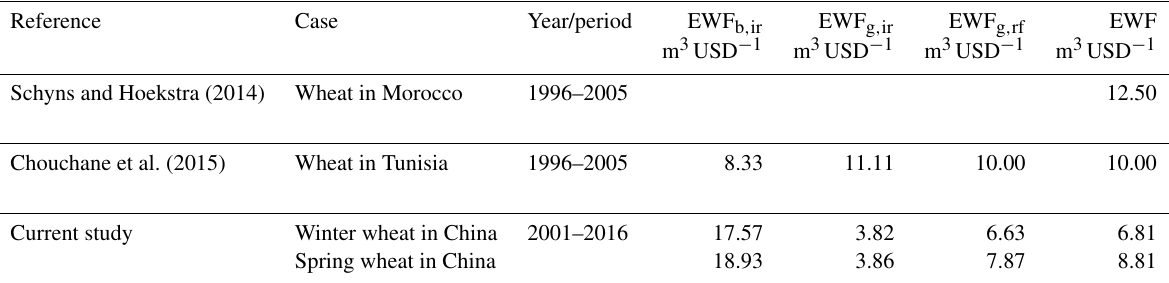
Table 6. Comparison between economic value-based water footprint (EWF) in the current results and previous studies.